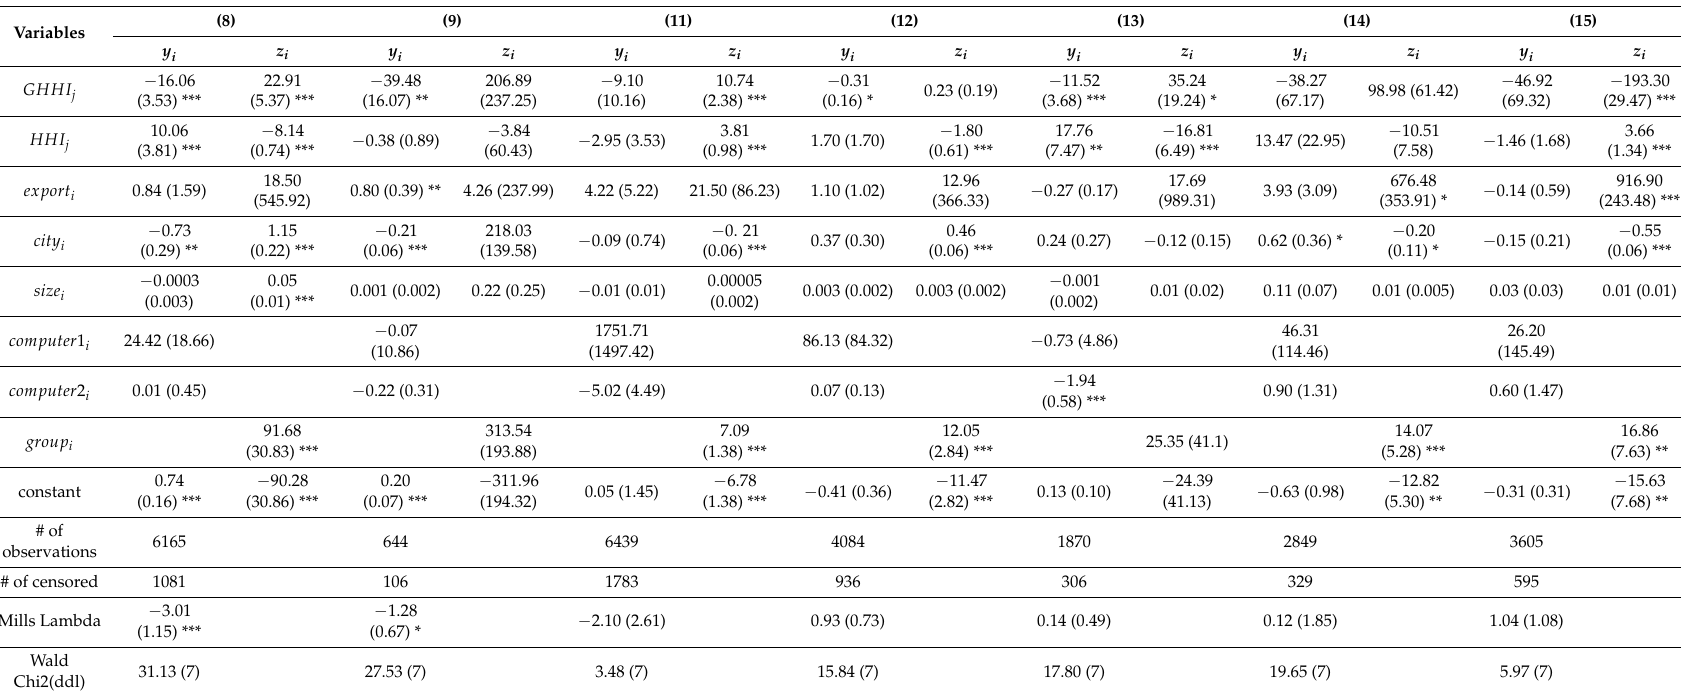
Table 8. Selection corrected internet intensity (with HHI) for 2-digit